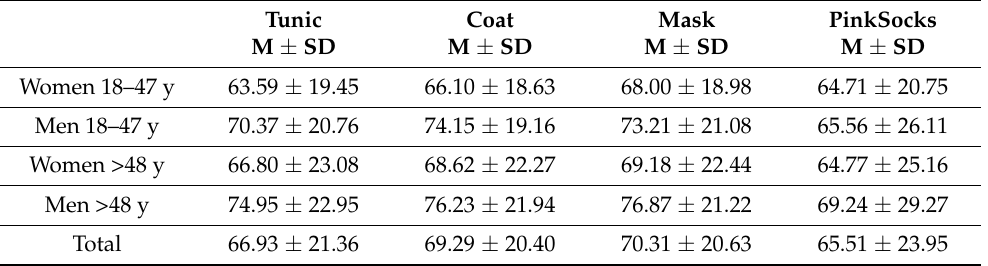
Table 2. Evaluation of the four photos according to competence (mean, standard deviation).